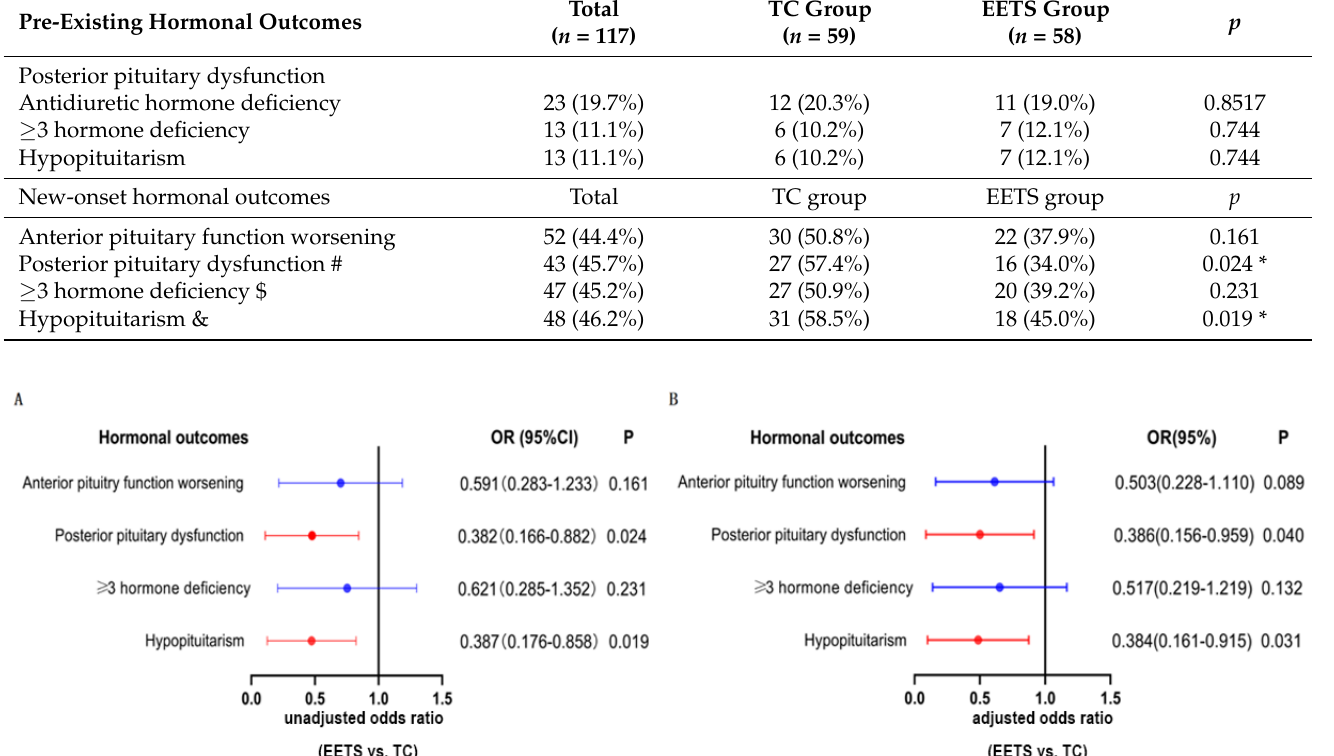
Figure 3. The association between the surgical method and hormonal outcomes. ( A ) The univariate logistic regression analysis; ( B ) The multivariate logistic regression analysis. The result showed that the EETS was an independent protective factor for posterior pituitary dysfunction (adjusted OR = 0.386, p = 0.04) and hypopituitarism (adjusted OR = 0.384, p = 0.031). The multivariate logistic regression analysis adjusted age, tumor size, sex, histopathology subtype, calcification, preoperative hypothalamic involvement, follow-up, and preoperative body mass index.